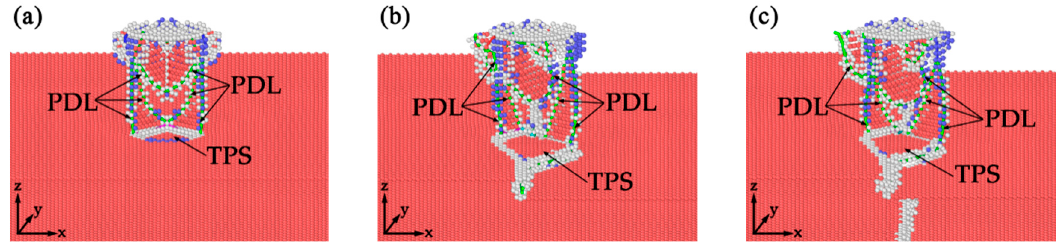
Figure 6. Initial defect structures in TPT, SDT, and TDT, respectively. The indenter depth is d = 5.0 Å. ( a ) TPT; ( b ) SDT; ( c ) TDT.